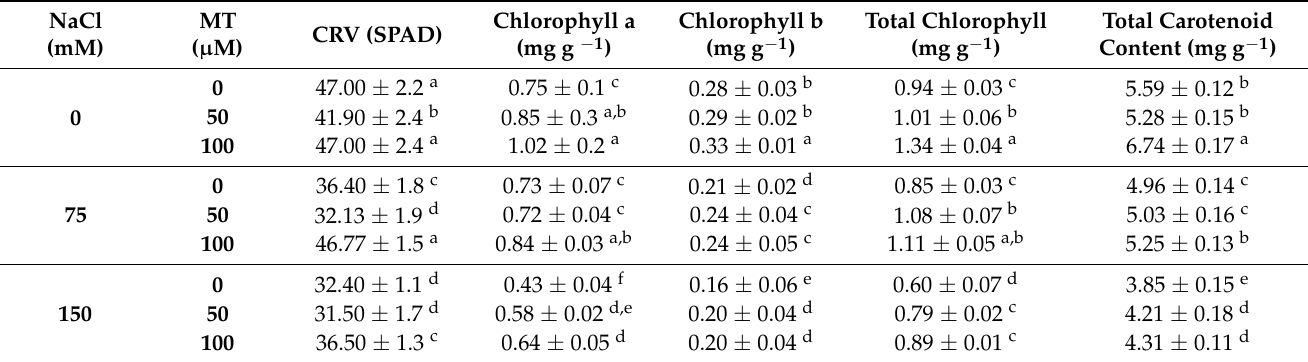
Table 2. CRV, chlorophyll a, b, total chlorophyll, and total carotenoid content response in leaves of the chickpea seedlings under salinity stress to MT